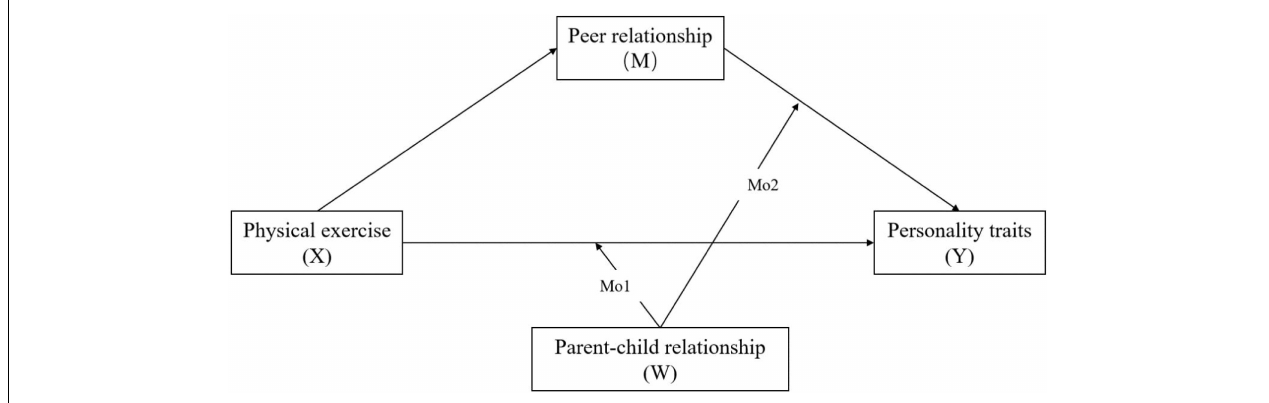
FIGURE 1 | Conceptual framework of the proposed moderated mediation